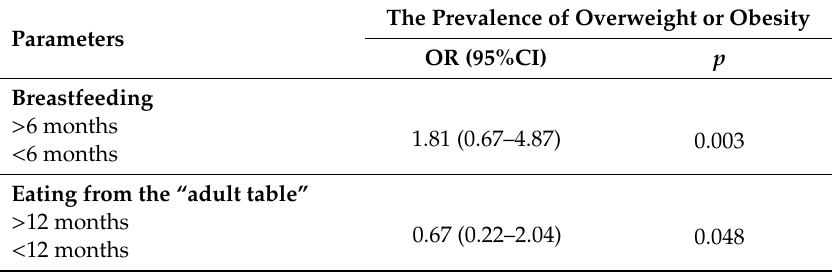
Table 5. Odds ratio (OR) of the occurrence of overweight / obesity depending on the length of breastfeeding and eating from the “adult